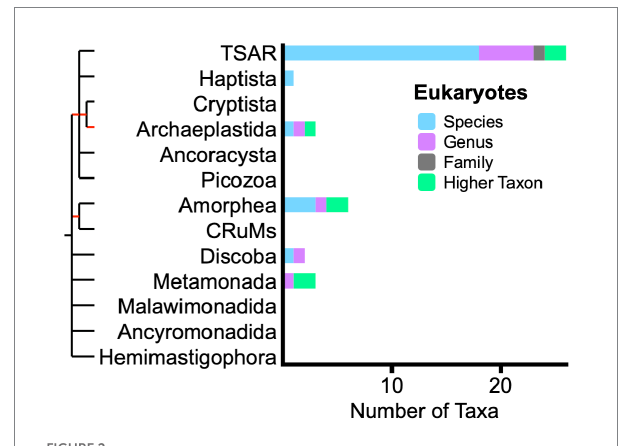
FIGURE 2 Phylogram with bar graph showing the distribution of living fossil taxa across Eukaryotes, excluding green plants and animals. Bar colors indicate taxonomic ranks of 41 unique taxon names. Red sections of phylogram indicate substantial uncertainty of relationship. Acronyms: TSAR supergroup (telonemids, stramenopiles, alveolates, and Rhizaria); CRuMs supergroup (collodictyonids, Rigifilida, and Mantamona).